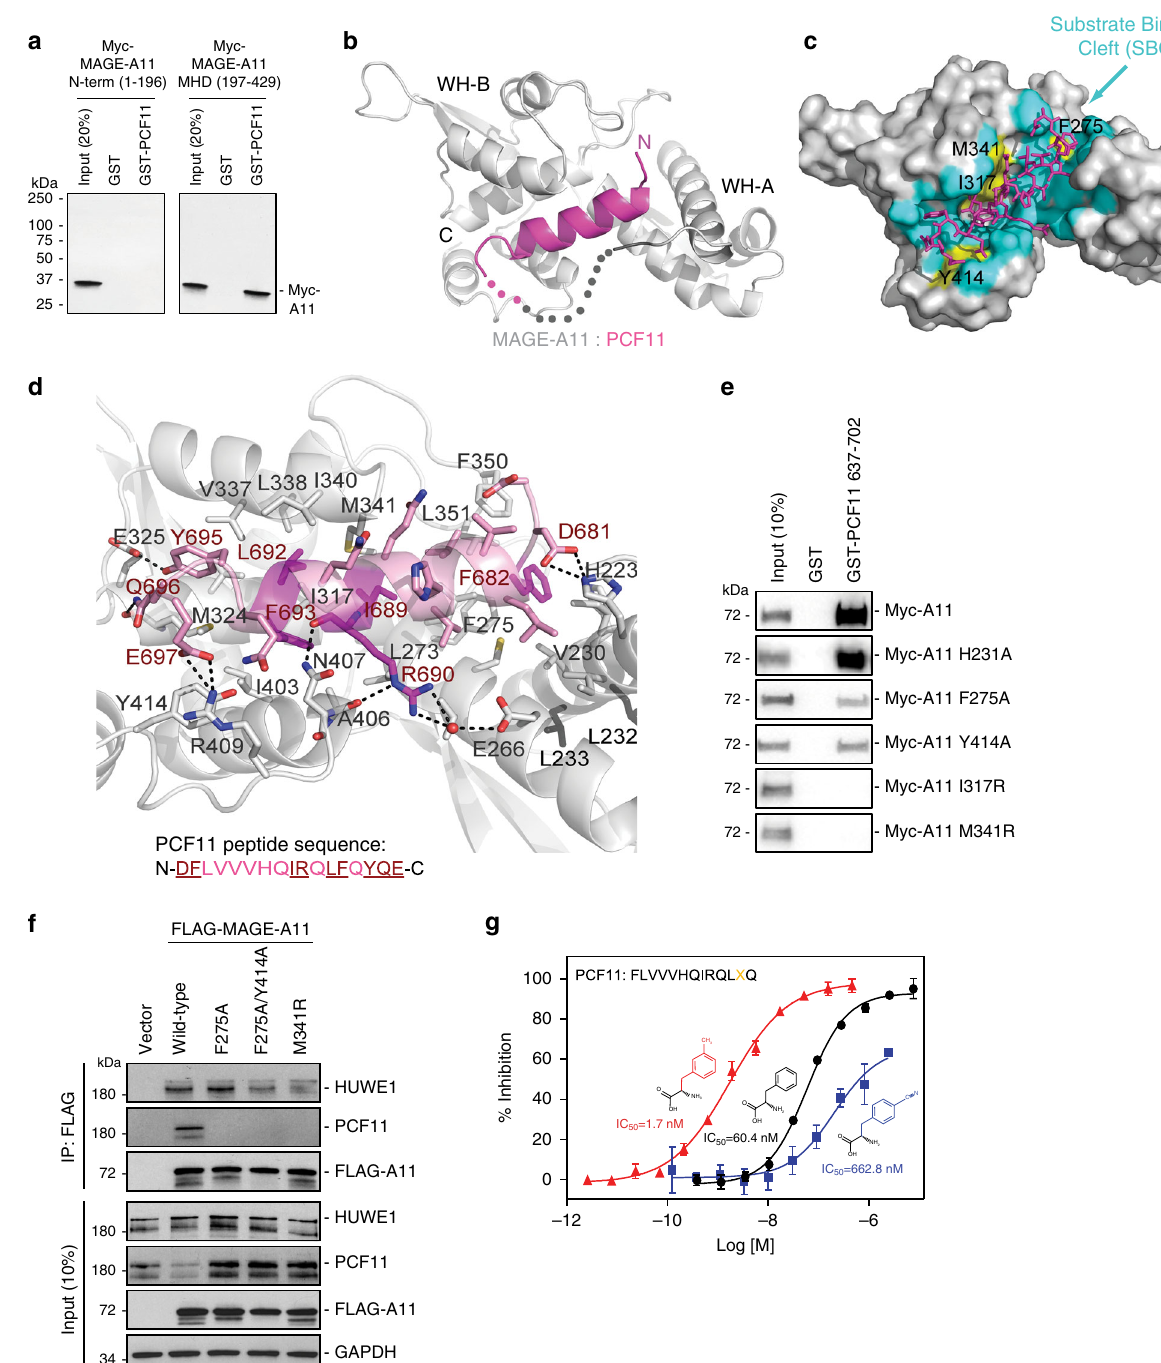
Fig. 2 Crystal structure of MAGE-A11:PCF11 identi fi es MAGE substrate binding cleft. a MAGE-A11 directly interacts with PCF11 through its MHD. In vitro translated Myc-MAGE-A11 MHD, but not N-terminal fragment, binds to recombinant GST-PCF11. Source data are provided as a Source Data fi le. b Overall structure of human MAGE-A11 MHD with human PCF11 degron peptide. The alpha-helical PCF11 degron peptide binds into SBC at interface of WH-A and WH-B motifs of MAGE-A11 MHD. PCF11 peptide is shown in pink and MAGE-A11 in gray. c MAGE-A11 atoms within 5 Å of PCF11 are colored cyan to indicate the SBC region. Residues in the SBC that are mutated in this study are labeled and colored yellow. d Substrate interaction is largely achieved by hydrophobic interactions along the alpha-helical interface of PCF11 with MAGE-A11 SBC. e Myc-tagged MAGE-A11 wild-type or mutants were in vitro translated and followed by in vitro binding assay with recombinant GST-PCF11 637-702 amino acids, SDS-PAGE and immunoblotting for anti-Myc. Source data are provided as a Source Data fi le. f MAGE-A11 SBC is crucial for PCF11 substrate binding, but not HUWE1 E3 ligase binding, in cells. HEK293FT cells stably expressing FLAG-vector, FLAG-MAGE-A11 wild-type or mutants were subjected to pull-down with anti-FLAG followed by SDS-PAGE and immunoblotting for anti-HUWE1 and anti-PCF11. Source data are provided as a Source Data fi le. g TR-FRET binding assays of GST-MAGE-A11 with PCF11 peptide (FLVVVHQIRQLF*Q) containing phenylalanine (black circles), 3-methyl-phenylalanine (red triangles) or 4-cyano-phenylalanine (blue squares) at the indicated position ( n = 2 biologically independent experiments with triplicates per peptide). Data are mean ±